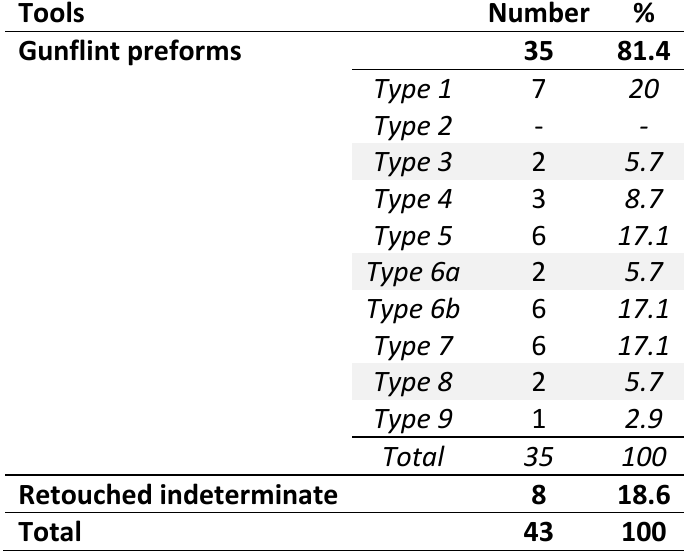
Table 5. Type of